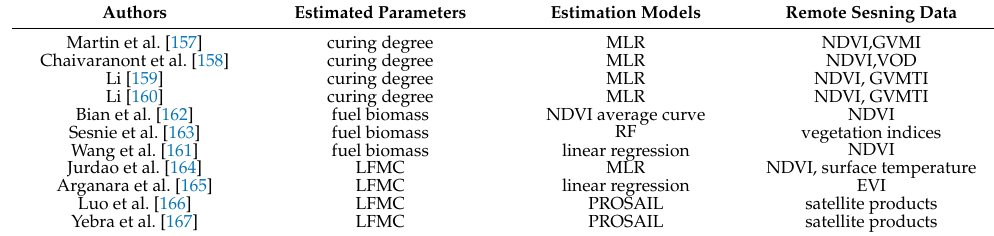
Table 9. The estimated parameters and their estimation models in the studies of fire risk